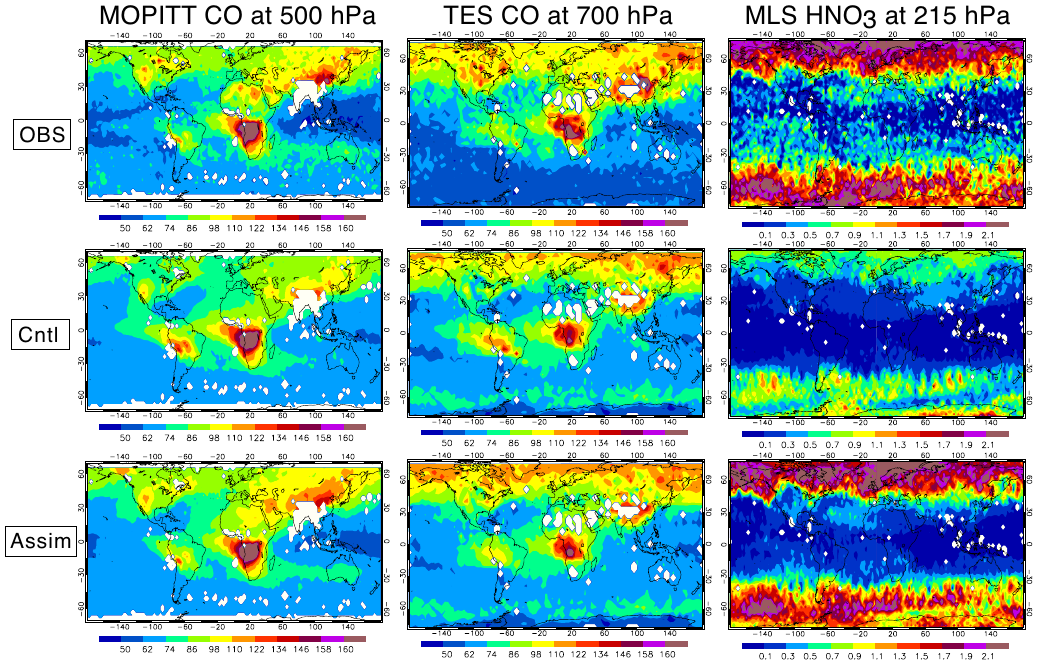
Fig. 10. Global distribution of the CO mixing ratio (in ppb) and HNO 3 mixing ratio (in ppb), averaged over 16–30 July 2007. The results are shown for MOPITT CO mixing ratio at 500hPa (left columns), TES CO mixing ratio at 700hPa (middle columns), and MLS HNO 3 mixing ratio at 215hPa (right columns). Upper row shows the satellite retrievals (OBS); centre row from the control run (Cntl); and lower row from the data assimilation run (Assim). The red (blue) colour indicates relatively high (low) values.